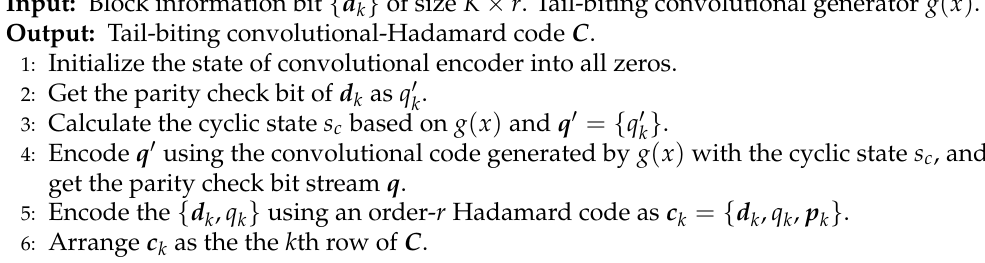
Algorithm 1 Tail-Biting Convolutional-Hadamard Encoder